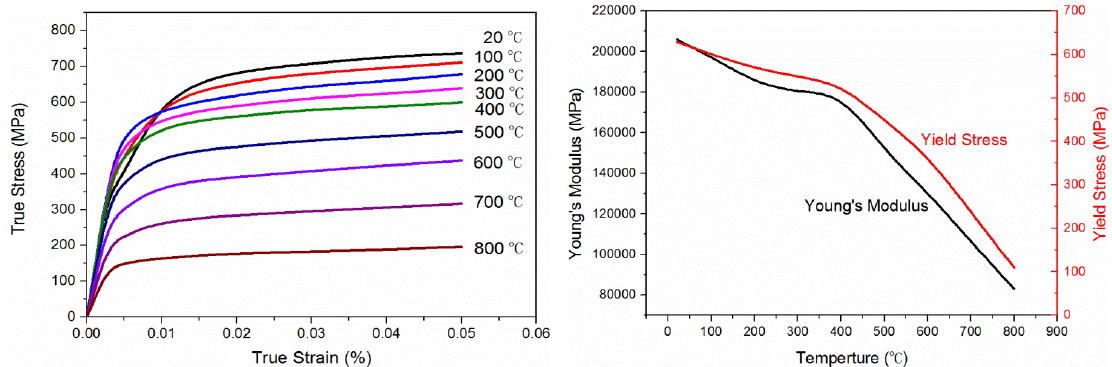
Figure 9. The true stress-strain, elastic modulus, and yield strength curves of 700 L at di ff erent temperatures. ( a ) The true stress-strain curves; ( b ) The elastic modulus and yield strength